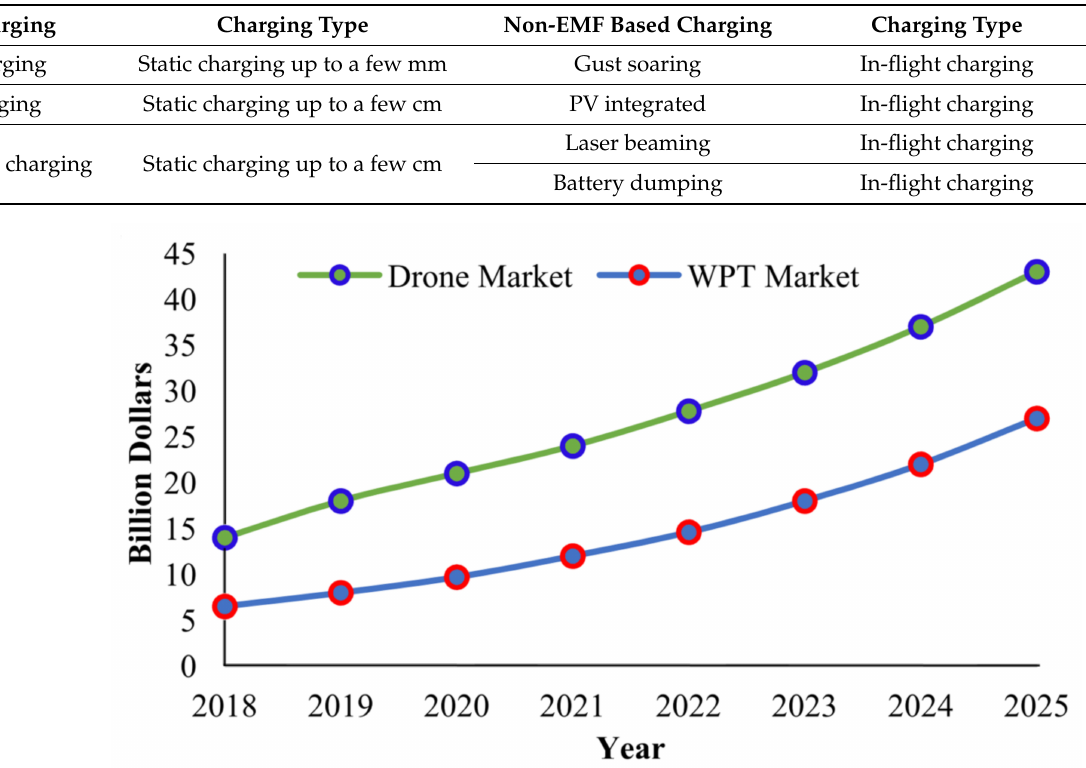
Table 1. Charging techniques to charge UAVs [4].